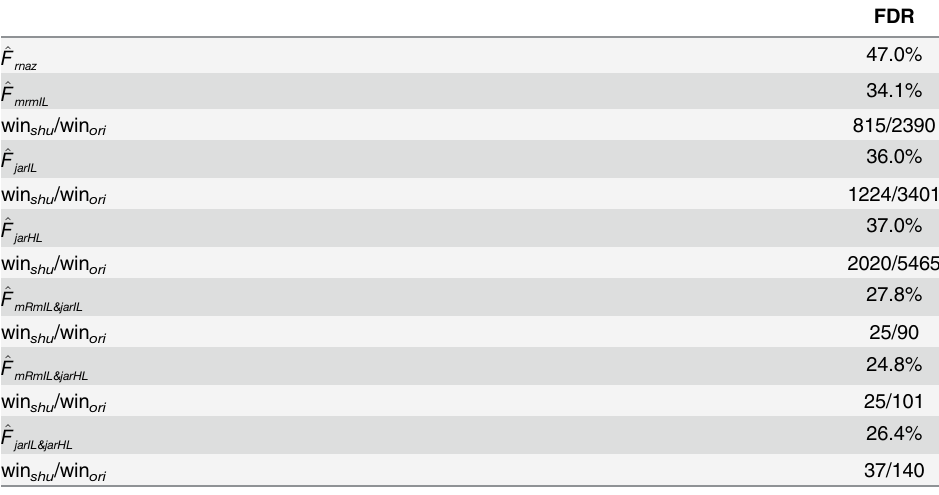
Table 2. False discovery rates for RNAz candidates (p-score > 0.9, 0.25 (cid:4) GC content (cid:4) 0.75) and 3D module predictions. Only 3D modules that are enriched and with an odds ratio (cid:1) 1.25 are taken into account. Furthermore, JAR3D IL modules have average 3D sequence length (cid:1) 9. Subscripts denote which method for module prediction is used. “ win shu /win ori ” shows the number of shuffled and original windows that match a 3D